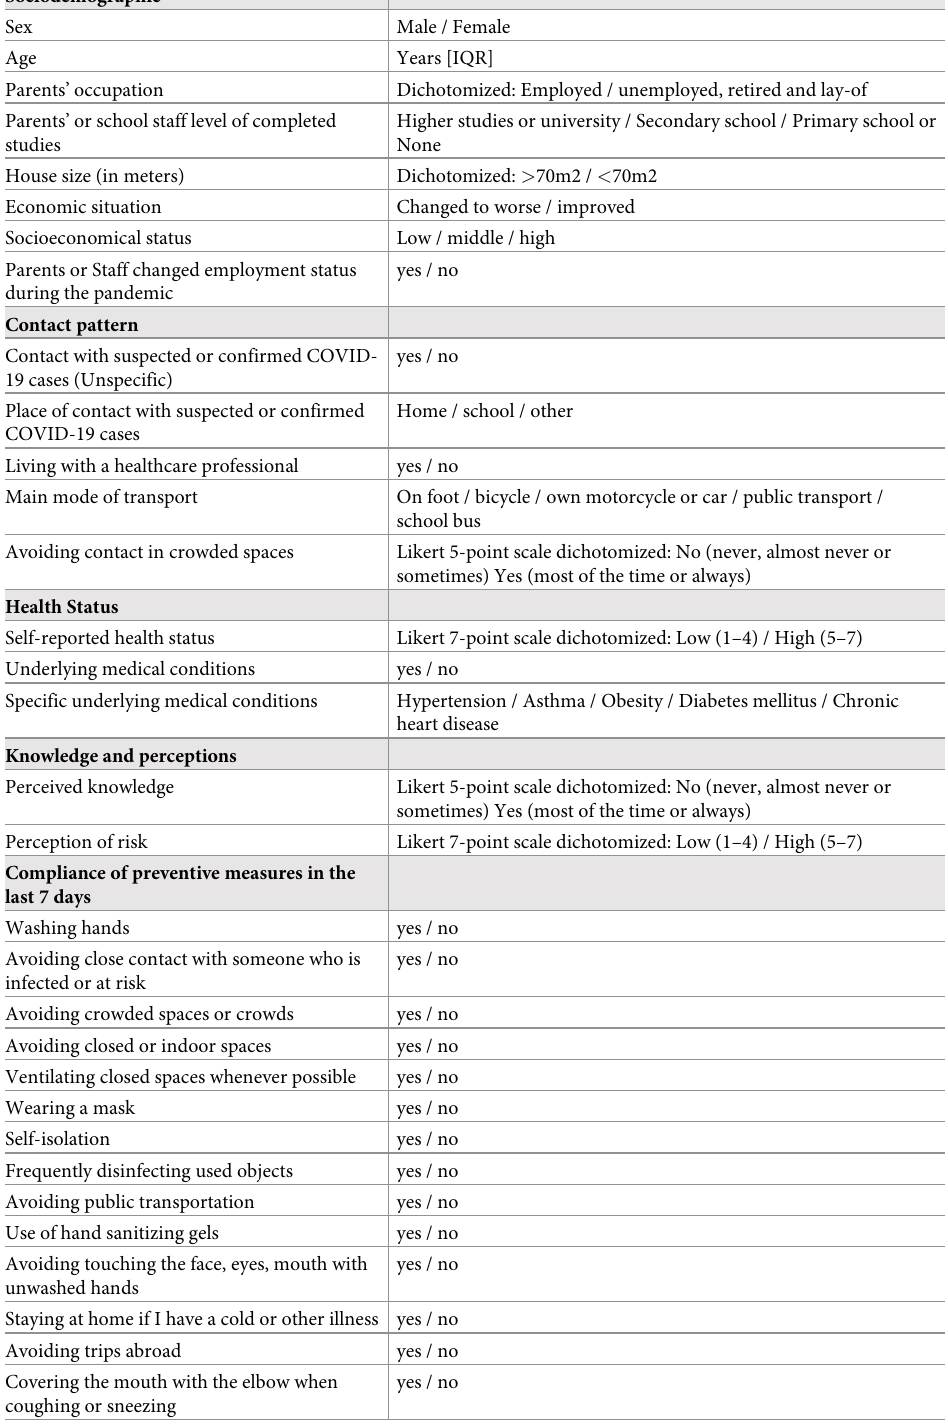
Table 1. Independent variables included in the study, CSSNC Catalonia, Spain